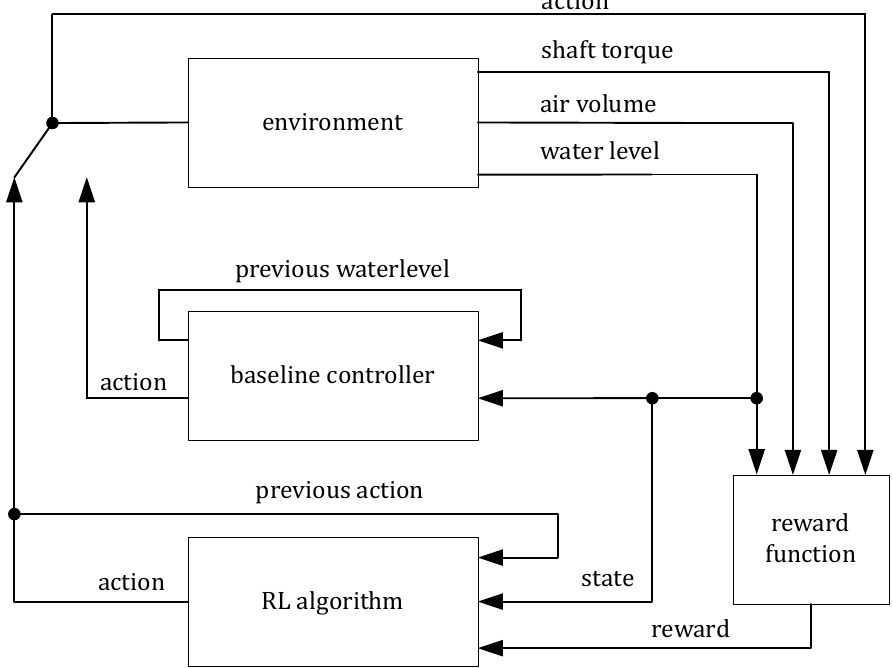
Figure 3. Formalized agent—environment interaction loop for the blow-out process test